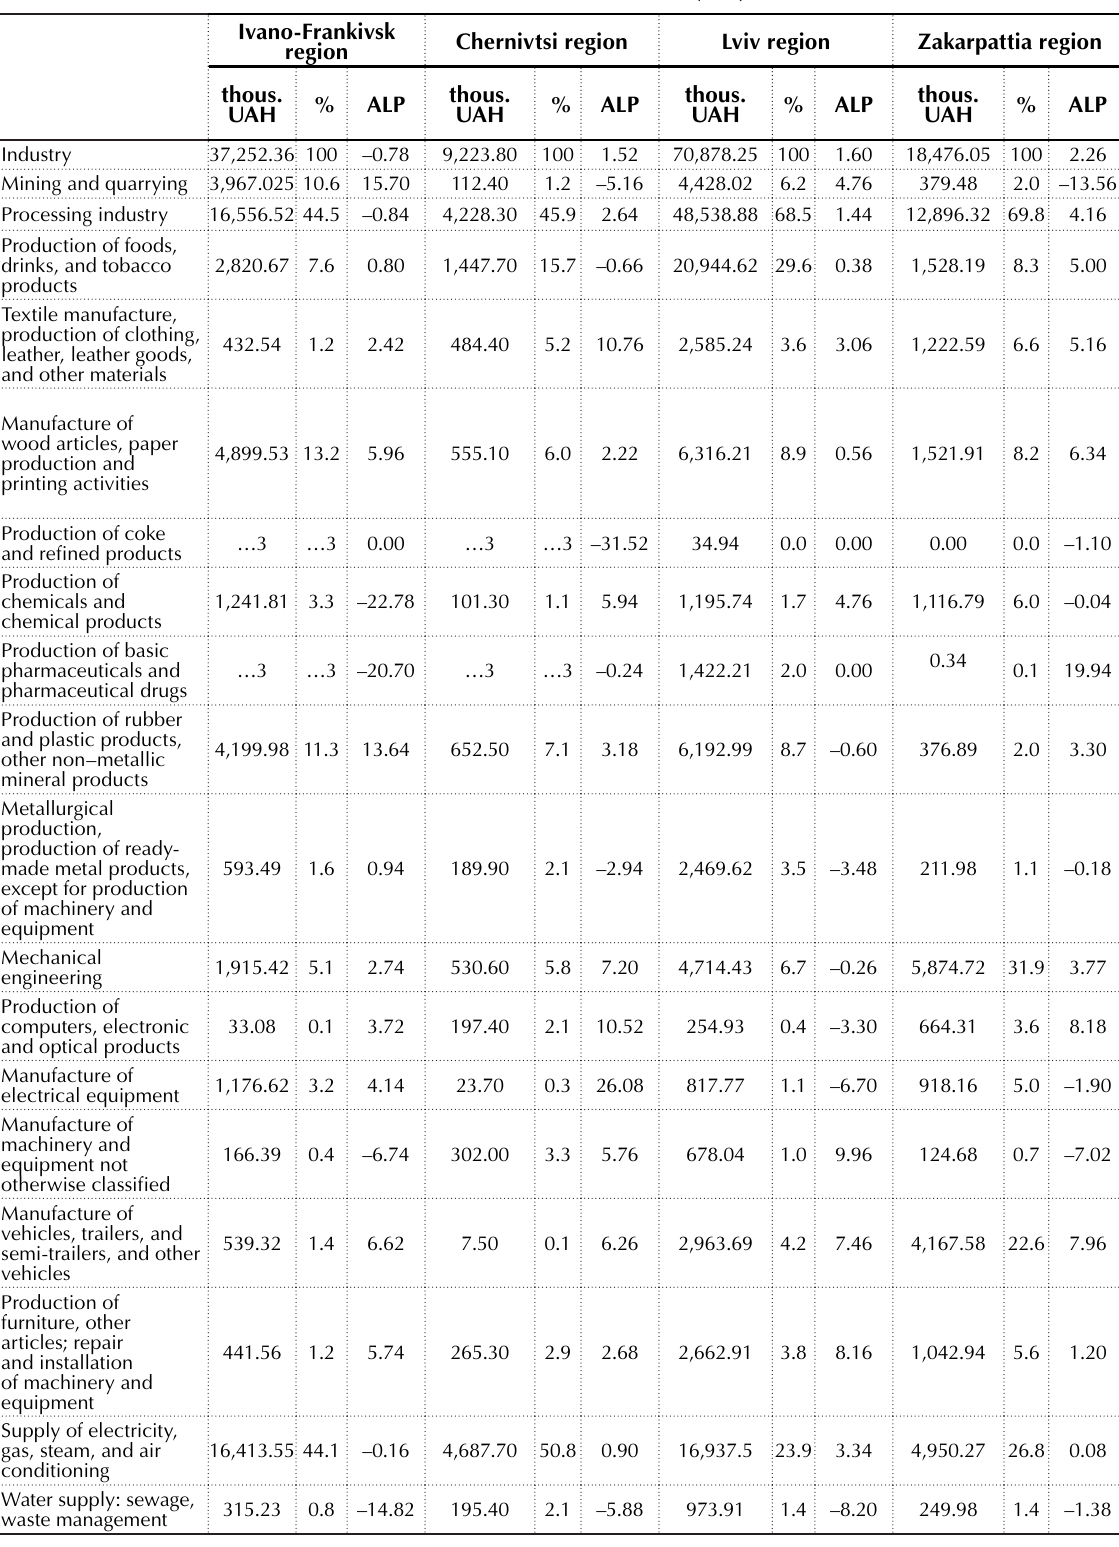
Table 4. Growth areas of the Carpathian economic region determined from the performance of the total industrial output (goods and services) by level of industry profitability for 2016 Source: developed by author on the basis of review of the information base Ivano-Frankivsk